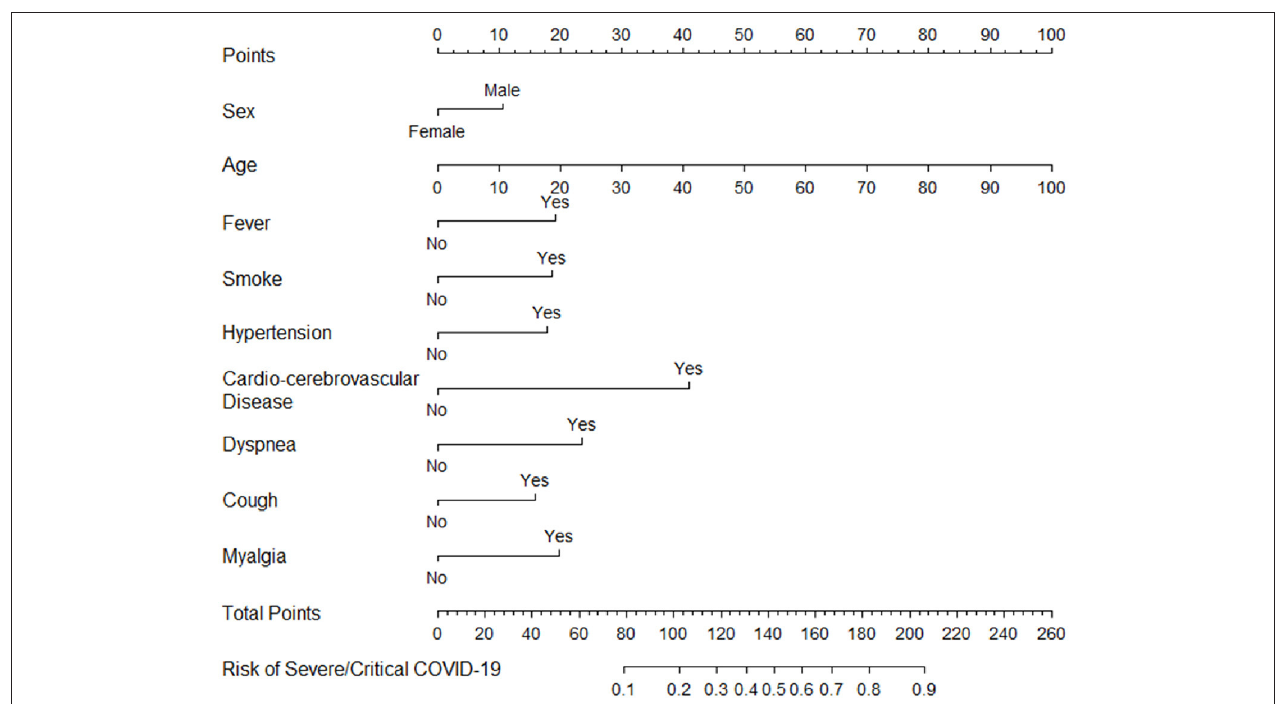
FIGURE 1 | Nomogram of probability to develop severe/critical COVID-19. To use the nomogram, draw an upward vertical line from each covariate to the points bar to calculate the number of points. Based on the sum of the covariate points, draw a downward vertical line from the total points line to calculate the probability of developing severe/critical COVID-19.